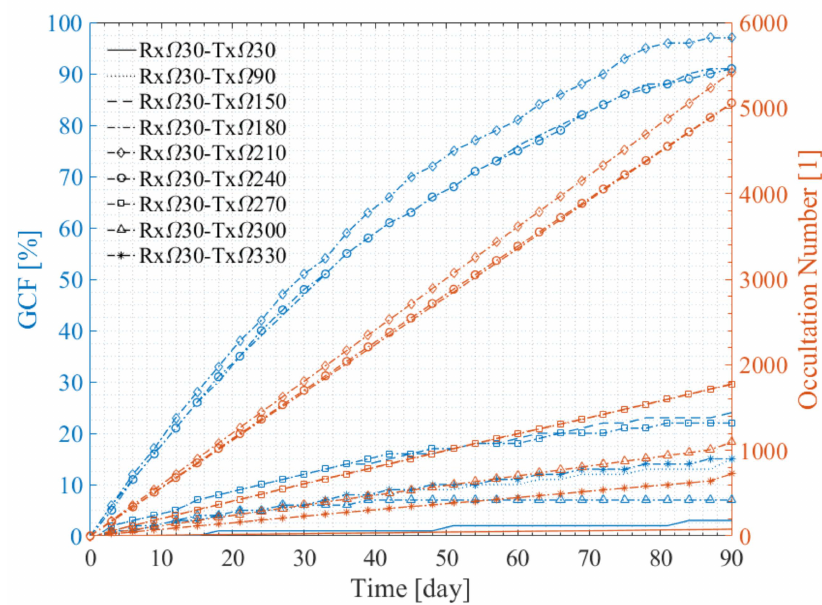
Figure 6. The accumulated time dependence of the LEO-LEO occultation event number (orange lines) and the global coverage fraction (GCF) (blue lines) for representative polar orbit constellations composed of a Rx satellite and a Tx satellite with particular orbital